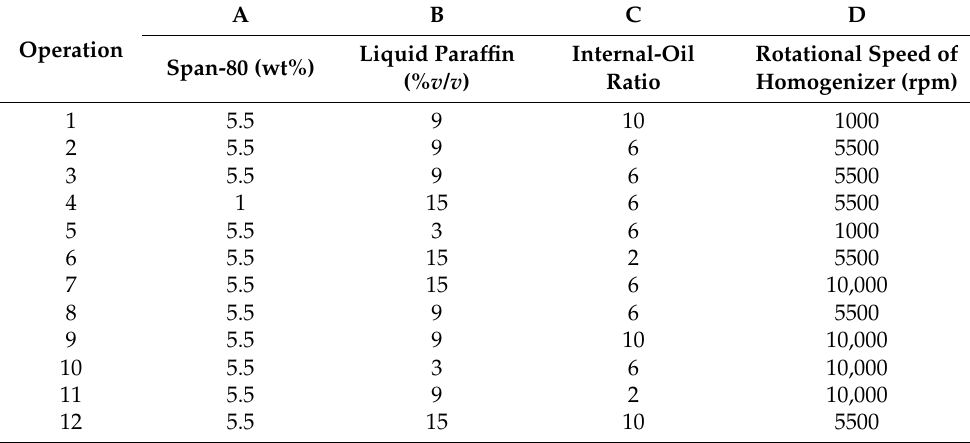
Table 5. Experimental value of the demulsification rate of the emulsion film and the predicted value of the RSM and ANN